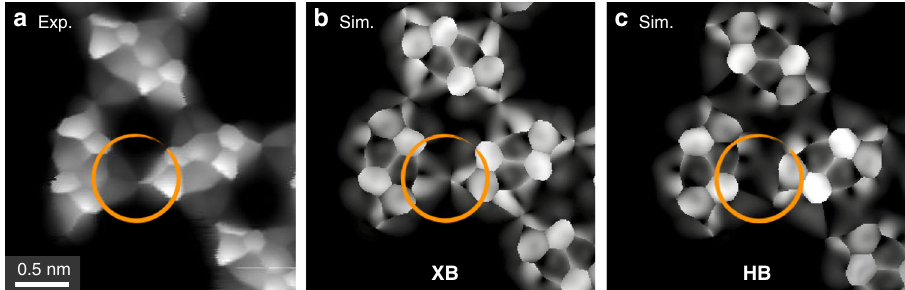
Fig. 5 Comparison between experimental and simulated HR-STM images of the 3,9-Br 2 PXX kagome assembly. a Constant height HR-STM image (same region as Fig. 4c). b Simulated HR-STM image (see text) of the XB assembly. c Simulated HR-STM image of the HB assembly. The orange circles highlight the O···Br/H region.